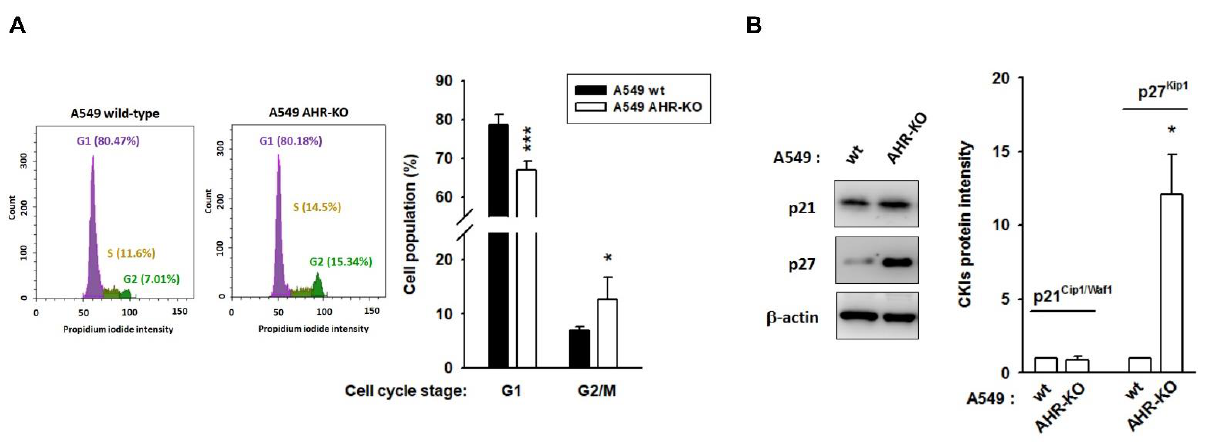
Figure 2. AHR-KO clones displayed G2/M phase arrest, involving the changing of a multitude of cell cycle regulators. ( A ) Using flow cytometry, the cell population of G1 phase was reduced, whereas the cell population of G2/M was increased in AHR-KO clones of A549 and BEAS-2B (Figure S2). ( B ) The expression levels of cell cycle regulators were examined. The G2/M arrest of A549 AHR-KO was strongly correlated with the induction of p27 Kip1 , a cyclin-dependent kinase inhibitor. (* p < 0.05, *** p < 0.001, indicates statistically significant difference from the wild-type). The changes of cyclin-dependent kinases (CDKs) and cyclins are shown in Figure S3.